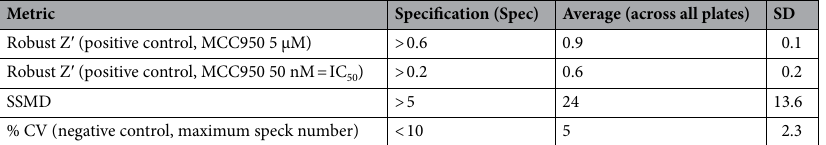
Table 1. Speck assay 81,000 high-throughput screening metrics. Assay plates were subjected to quality control analysis, evaluating the performance of each plate using positive (MCC950 50 nM and 5 µM) and negative (vehicle, DMSO) controls. The quality assay control acceptance criteria selected were robust Z ′ > 0.6 (MCC950 5 µM; maximum speck number reduction), robust Z ′ > 0.2 (MCC950 50 nM = IC 50 ). SSMD > 5, % CV < 10% (negative control, maximum speck number). Screening metric averages and standard deviations across plates are